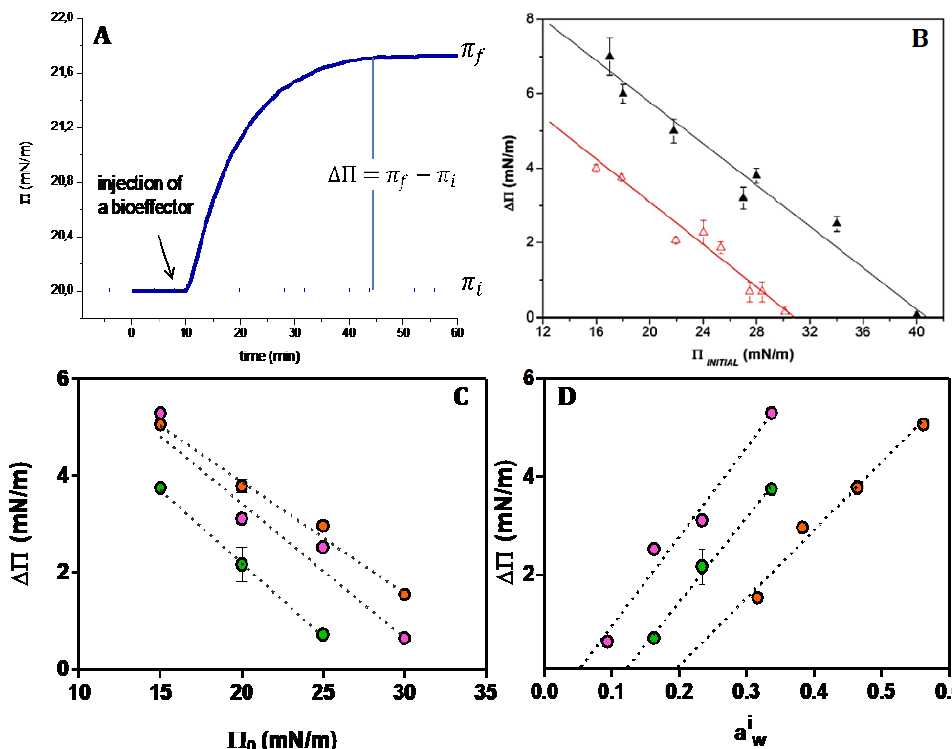
Figure 3. Perturbation of a responsive membrane to the different bioffectors. ( A ) Typical changes of the monolayer surface pressure upon the addition of a bioeffector. ( B ) Difference of the final and initial surface pressure for different initial surface pressures induced by a soluble protease as a bioffector on DMPC ( ∆ ) and DMPE ( ∆ ) monolayers (taken from Ref. [55]). ( C ) Difference of the final and initial surface pressure for different initial surface pressures induced by chlorogenic acid on DPPC ( • ), Di 16:0 ether PC ( • ), DMPC ( • ) (taken from Ref. [56]). ( D ) Difference of the final and